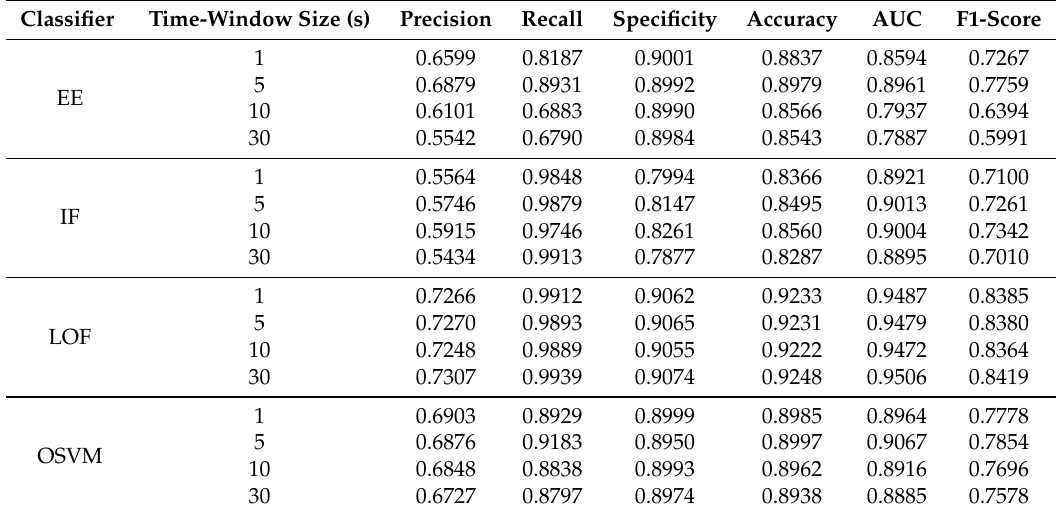
Table 3. Evaluation of time-window size for EE, IF, LOF and OSVM in all datasets.